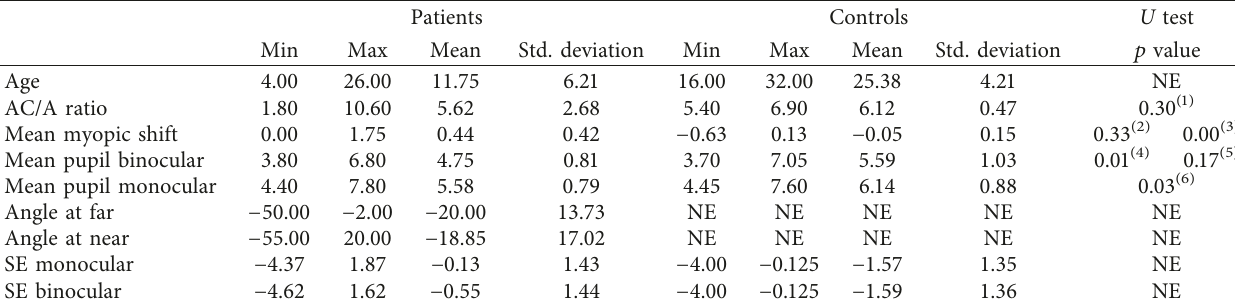
Table 2: Group B: descriptive statistics for patient group and control group (Mann–Whitney U test).